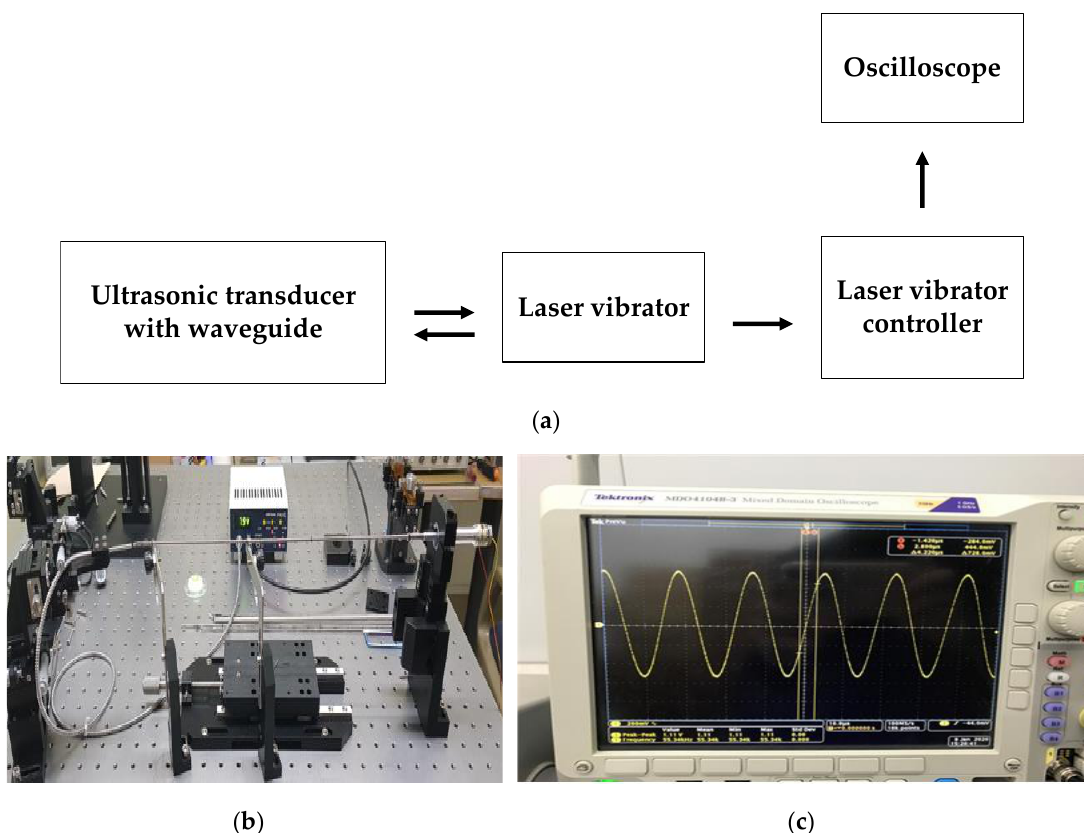
Figure 16. ( a ) Setup diagram and ( b ) picture to measure the amplitude and vibration of the BLUTs; ( c ) measured voltage signal in the oscilloscope.